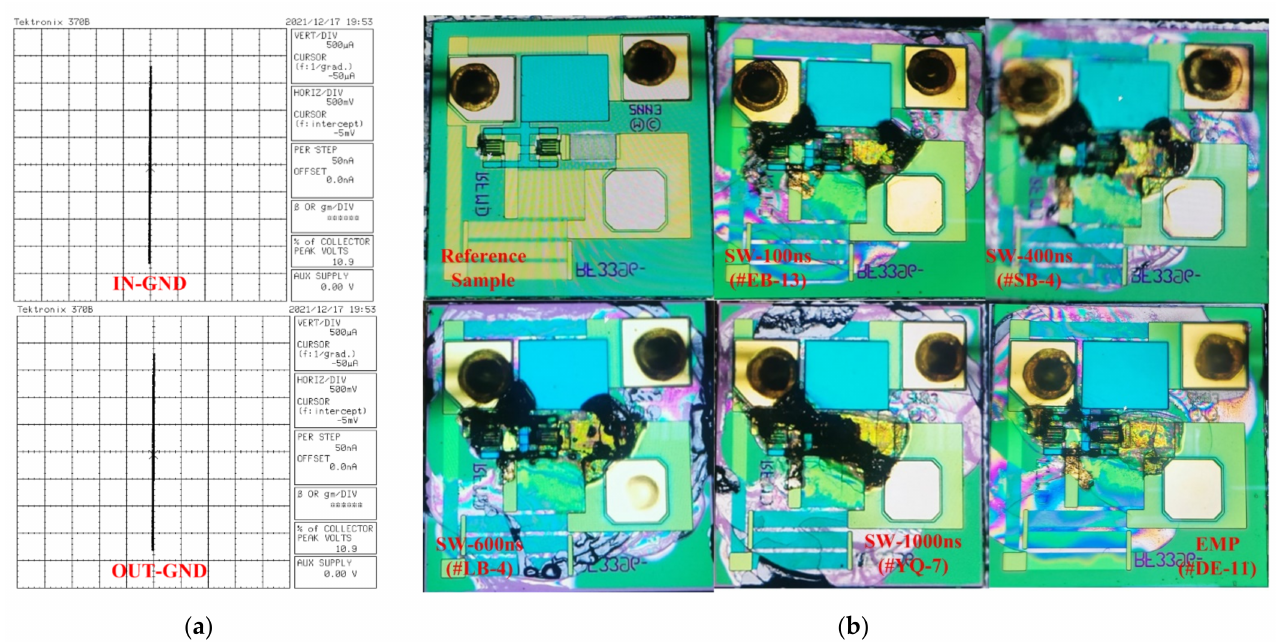
Figure 10. Effect mechanism detection result: ( a ) I-V characteristics; ( b ) Optical microanalysis.